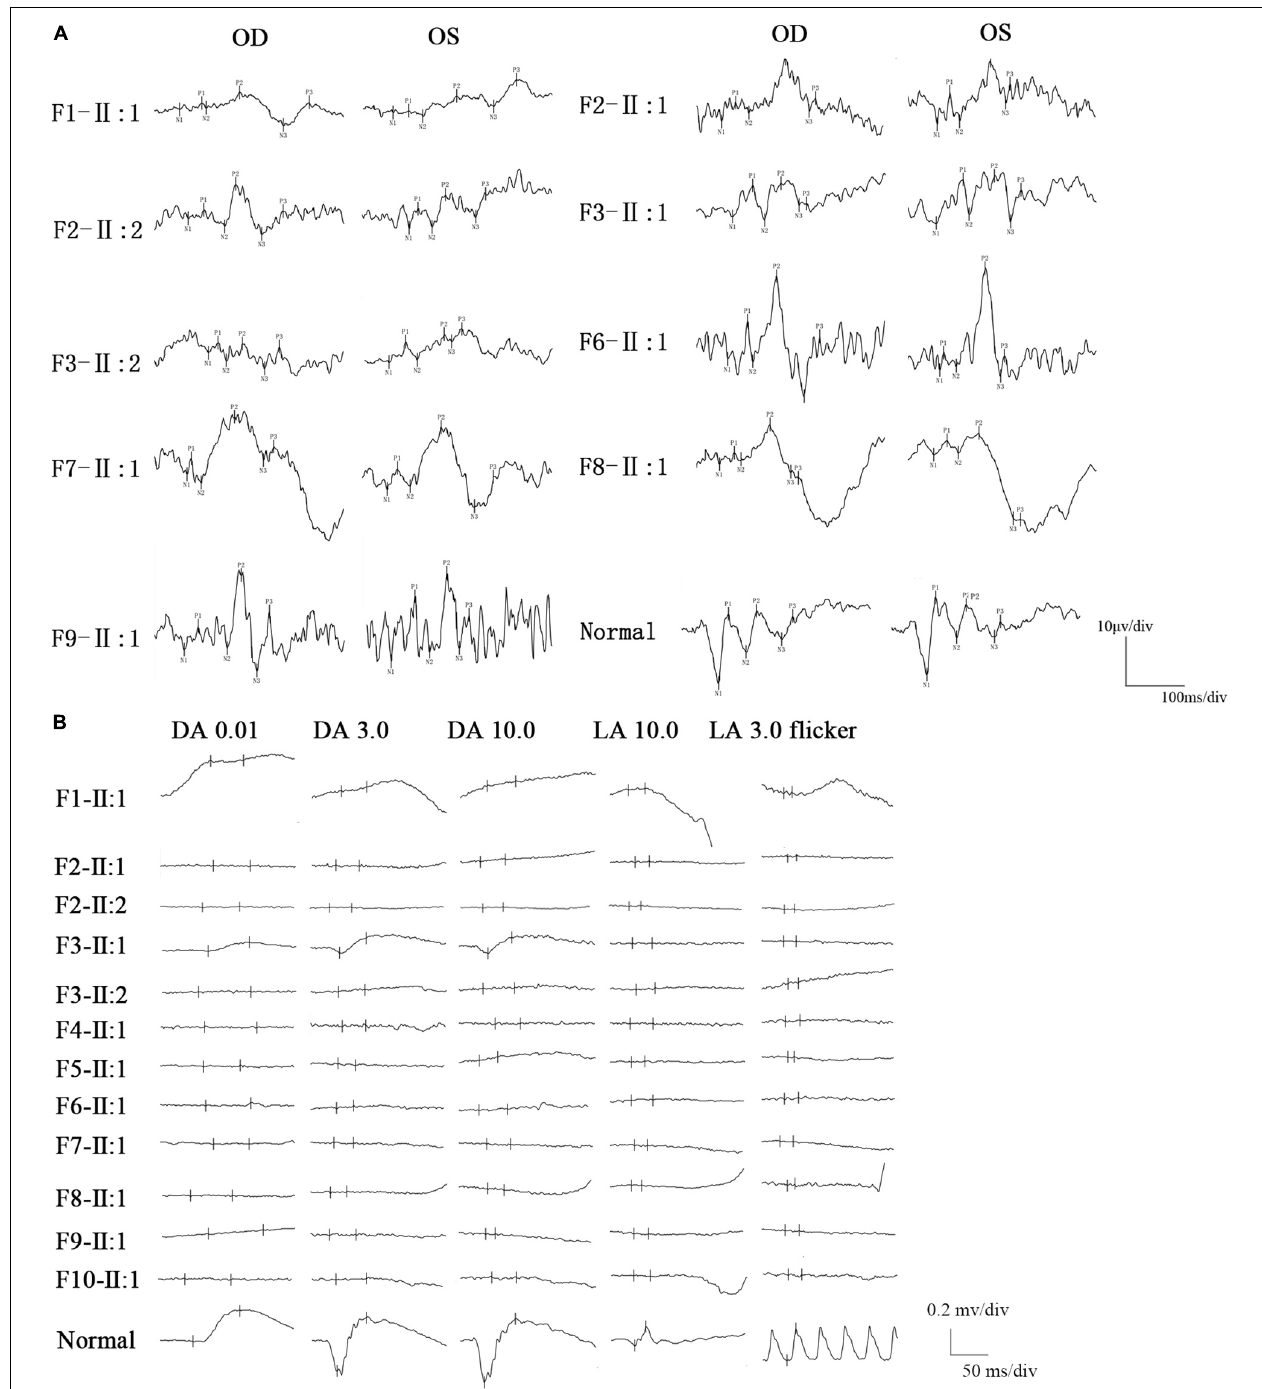
FIGURE 3 | FVEP and ffERG recordings in patients with BBS. (A) The FVEP showed mild delayed but visible P2 waves in patients who performed it. Interestingly, all of six patients who showed moderate reduced P2 wave amplitude, also had BCVA better than 0.01 (F2-II:1, F2-II:2, F3-II:1, F6-II:1, F7-II:1, F8-II:1). (B) The ffERG was unrecordable in most of the patients, only patient (F3-II:1) had partial residual rod response.